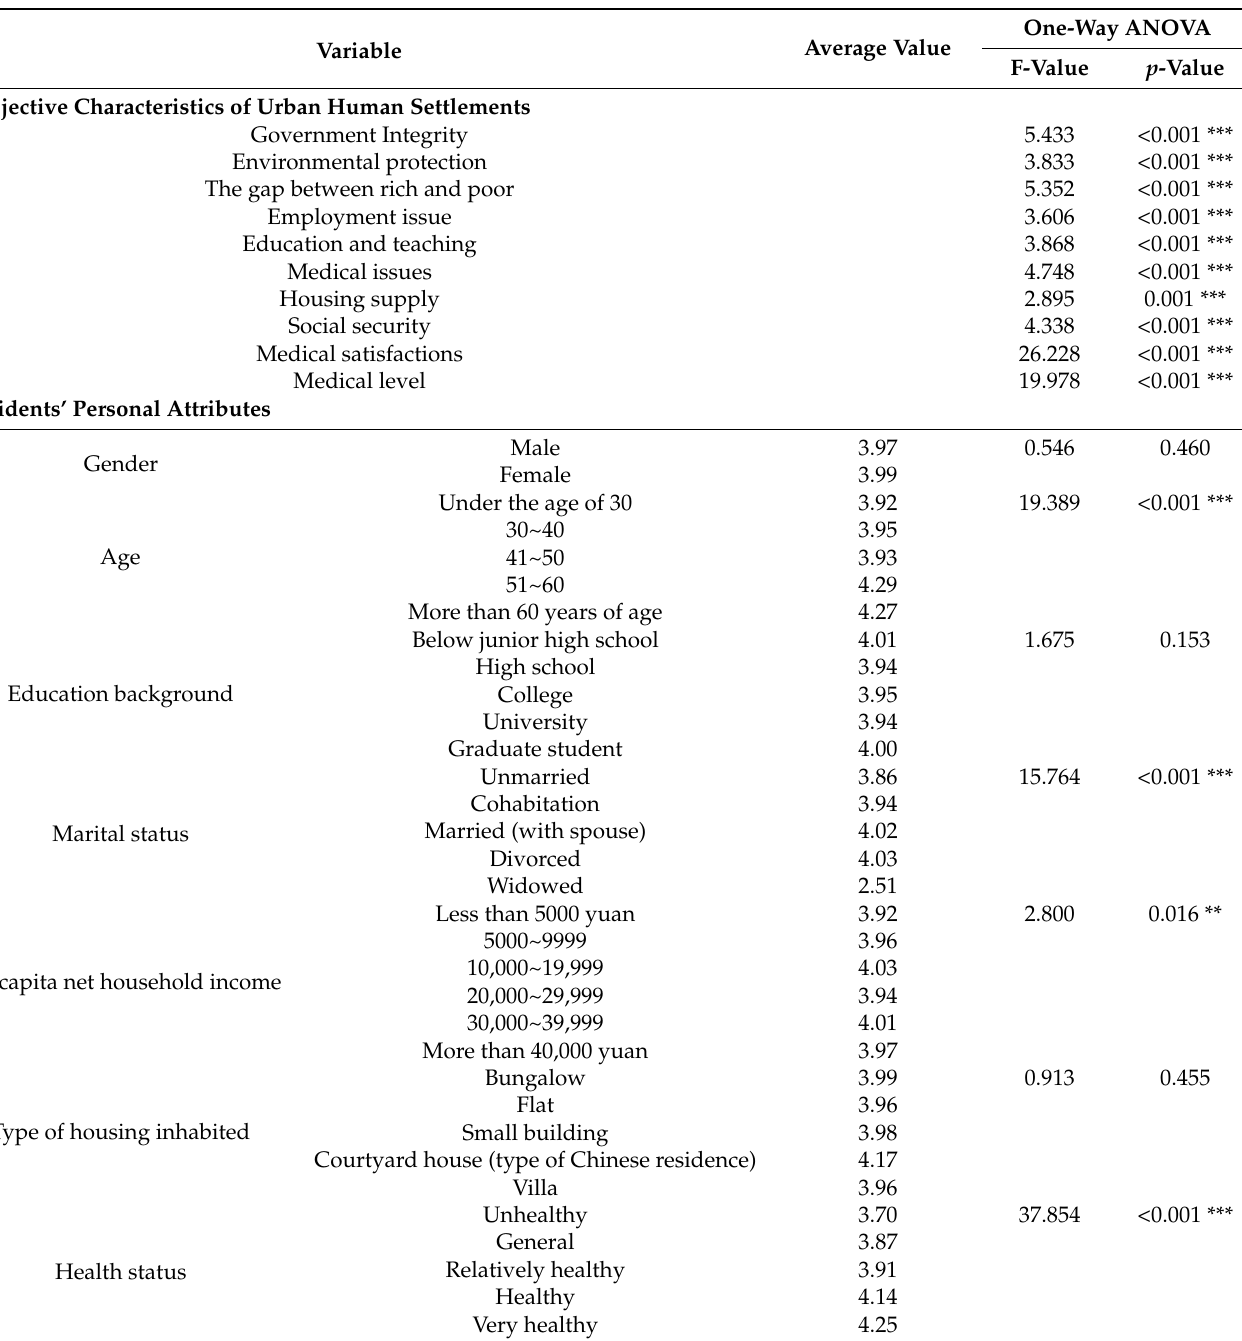
Table 3. Comparison of life satisfaction characteristics of